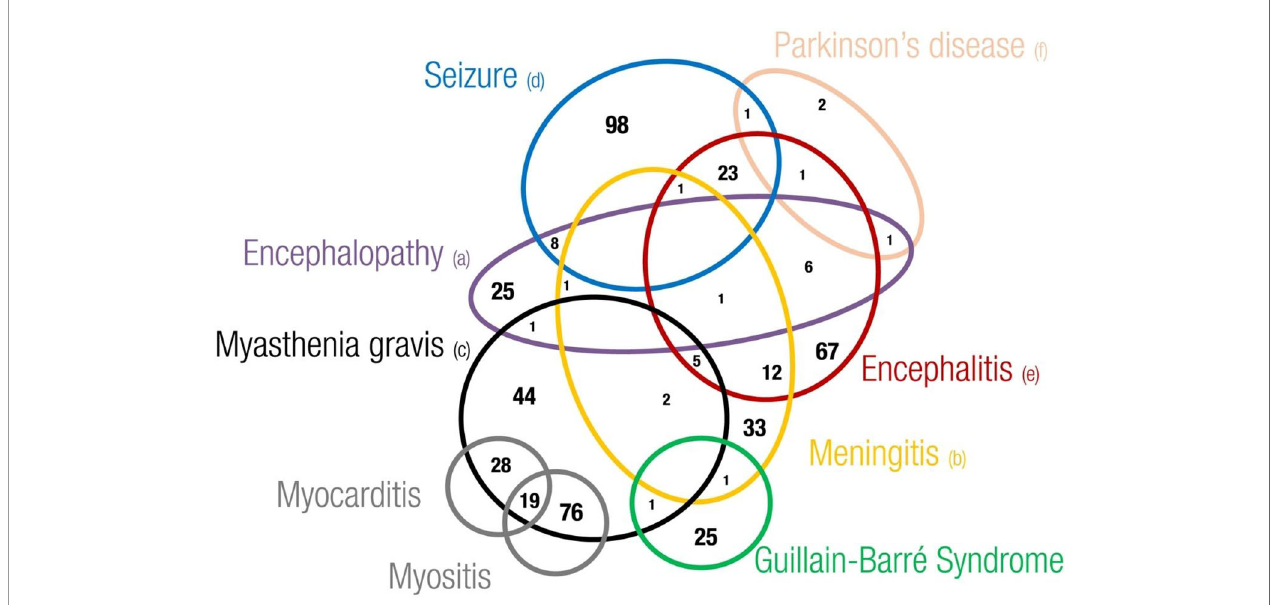
FIGURE 5 | Eulero Venn diagram showing overlapping between neurotoxicities of main interest. (a) Encephalopathy includes leukoencephalopathy hypoxic- ischaemic encephalopathy, encephalopathy, hepatic ence-phalopathy, posterior reversible encephalopathy syndrome and autoimmune encephalopathy (b) Meningitis includes meningism, meningitis, meningitis aseptic, meningitis tuberculous, meningitis noninfective, meningeal disorder, meningitis listeria, meningitis viral and pachymeningitis (c) Myasthenia gravis includes myasthenia gravis and mya-sthenic syndrome (d) Seizure includes epilepsy, clonus, myoclonus, partial seizures, generalised tonic-clonic seizure, seizure, seizure like phenomena, status epilecticus and tonic convulsion (e) Encephalitis includes encephalitis, ence-phalitis toxic, encephalitis autoimmune, limbic encephalopathy and noninfective encephalitis (f) Parkinson's disease includes Parkinson's disease and